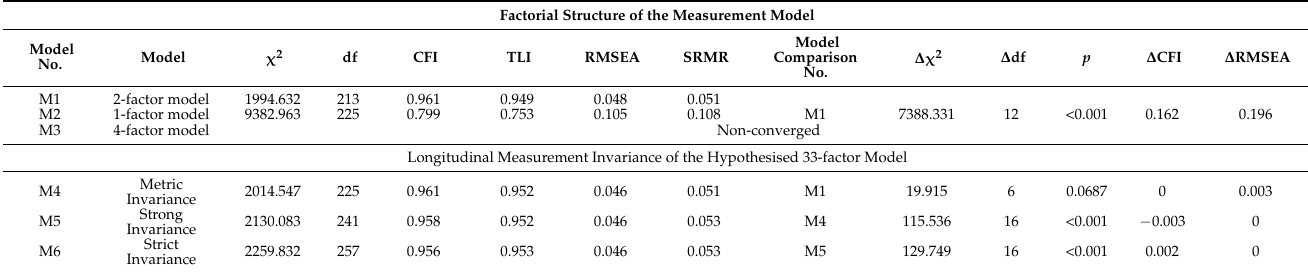
Table 2. Fit indices of competing nested factor models and standardised maximum likelihood